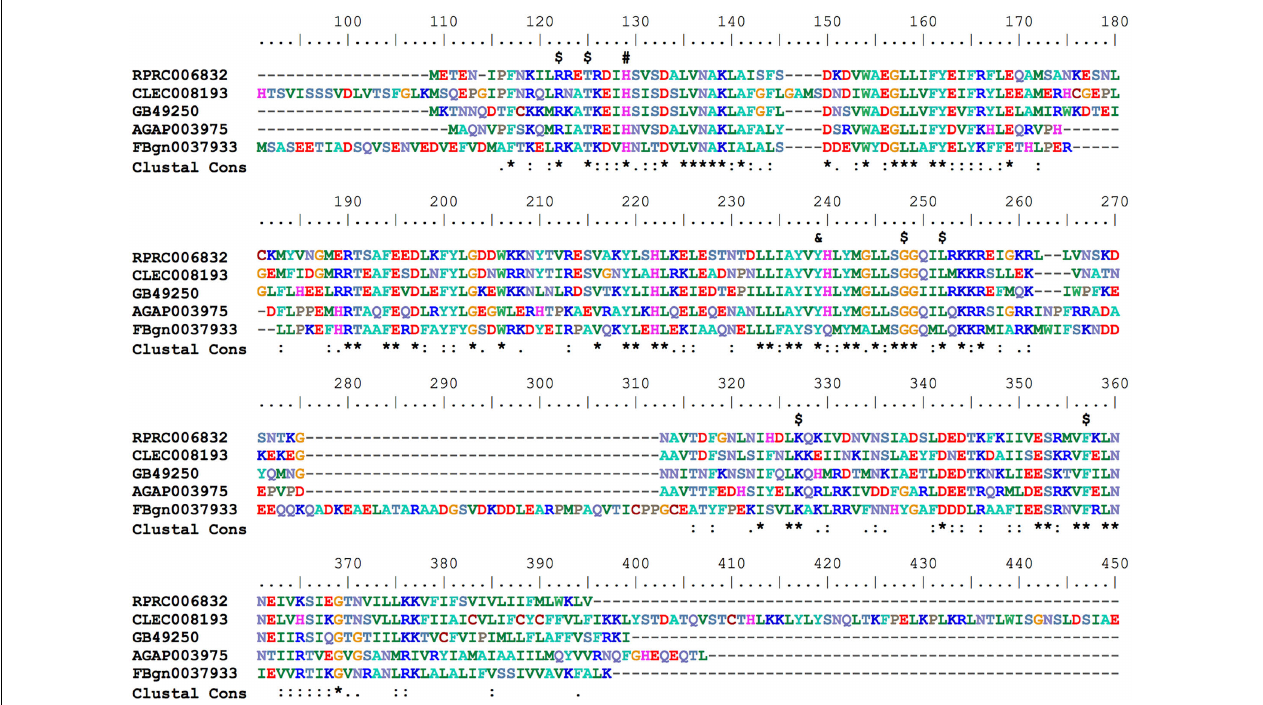
FIGURE 8 | Multiple amino acid sequence alignment of R. prolixus Heme Oxygenase. Amino acid color code generated by ClustalW within BioEdit software was used. Consensus residues (“Clustal cons” line) were generated by ClustalW. Conserved amino acids are indicated as follows: “$” heme binding pocket, “#” histidine that coordinates to heme iron and “&” tyrosine that binds to heme propionate. The CLEC008193 sequence was much longer than the other orthologs so its unaligned N-terminal (before His91) and C-terminal (after Glu409) sequences are not shown.